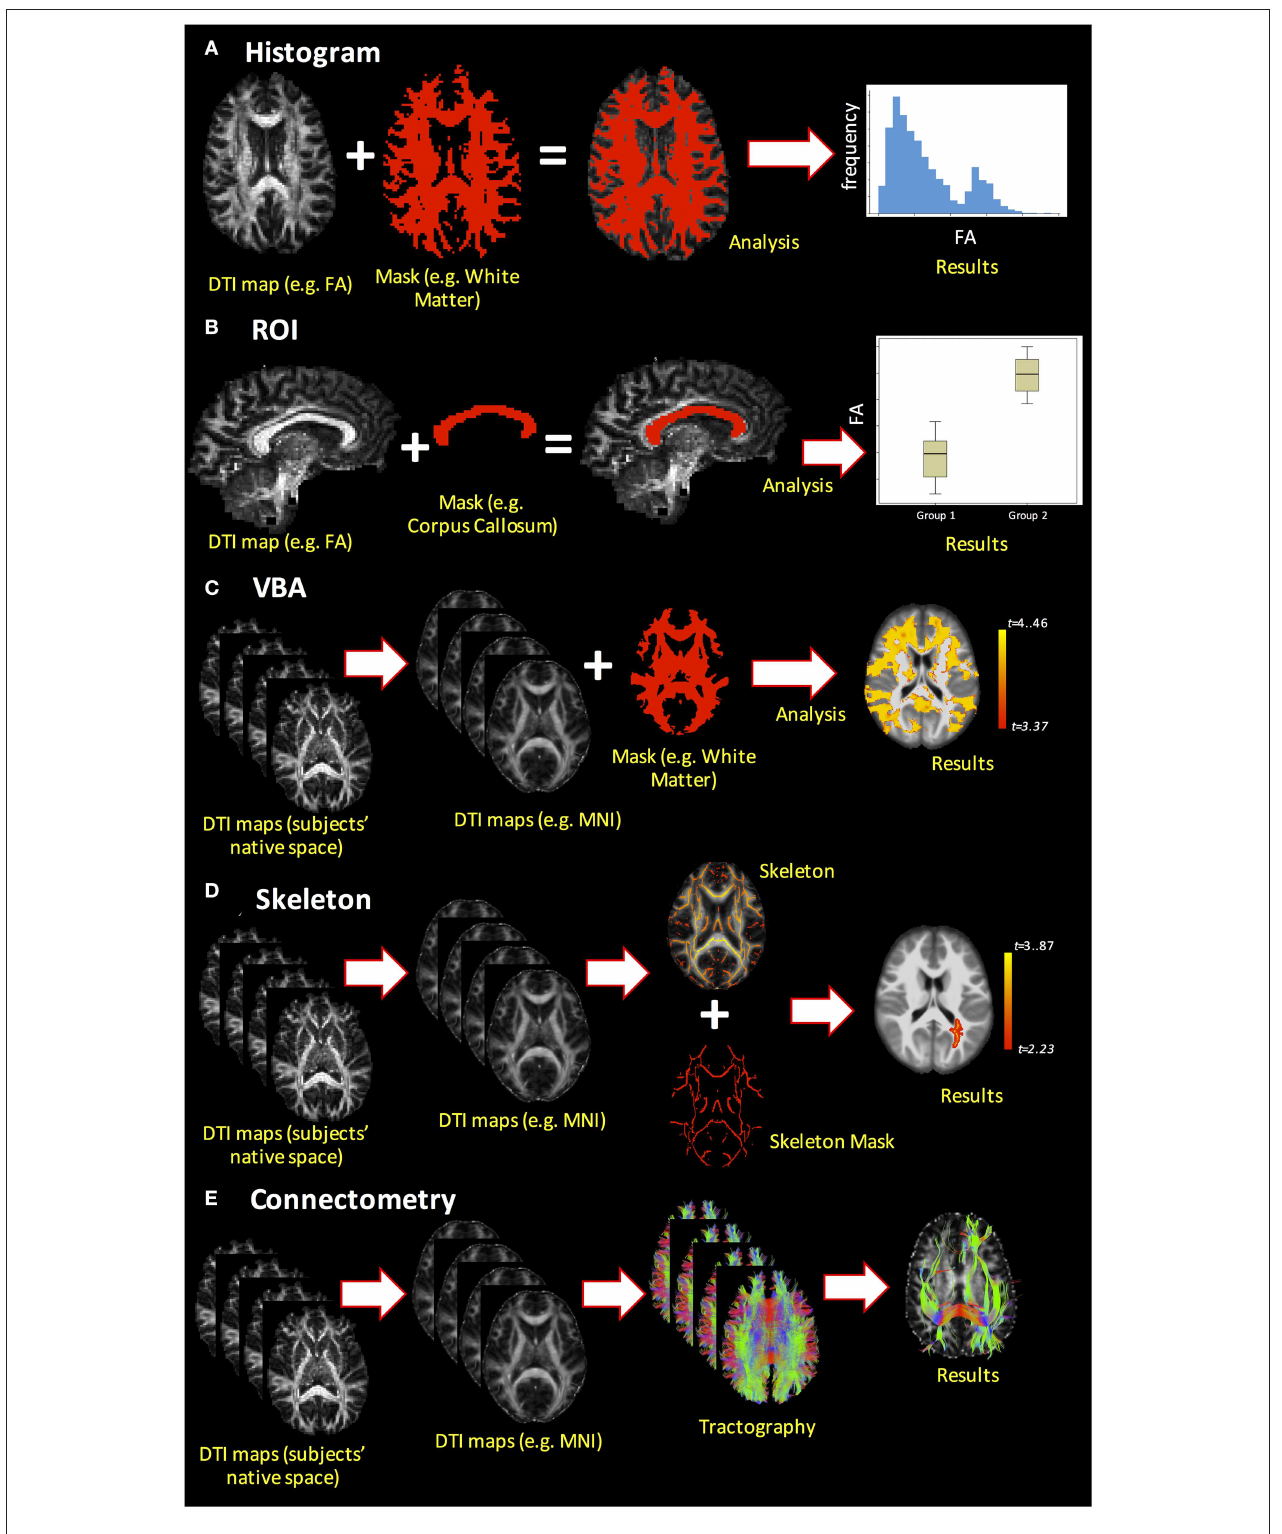
FIGURE 5 | Example of the different dMRI analysis methods. (A) Histogram analysis; (B) ROI analysis; (C) voxel-based analysis (VBA); (D) skeletonized analysis (e.g., TBSS pipeline); (E) connectome analysis.